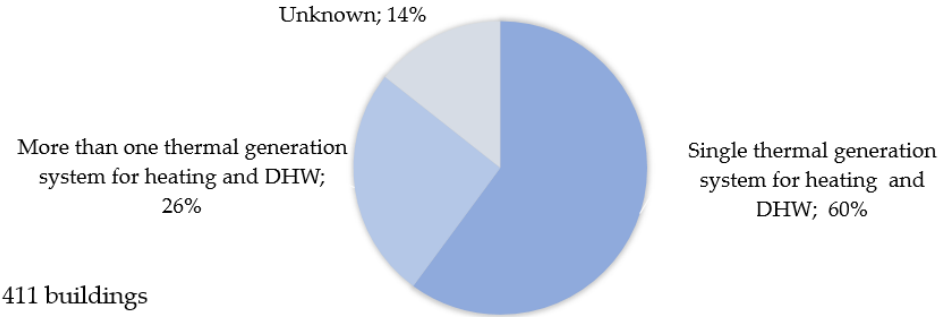
Figure 14. Heating and DHW systems used in nZEBs collected.